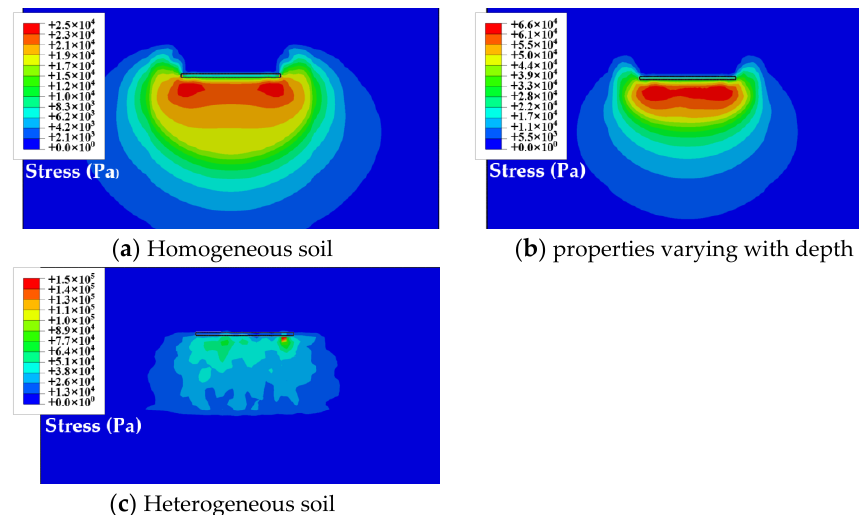
Figure 34. Soil stress contours of three soil types.